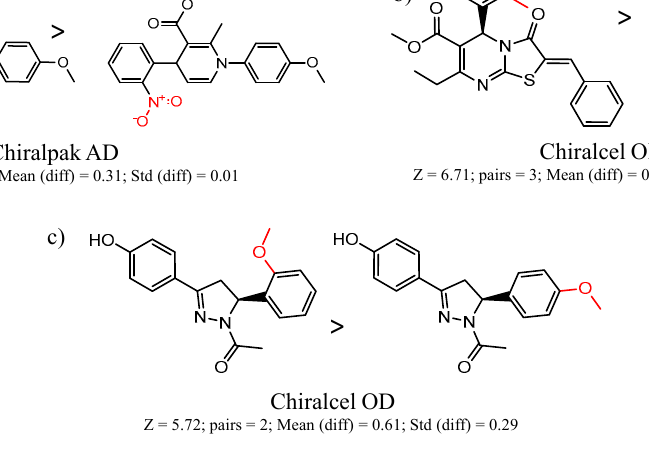
Figure 8. Matched Molecular Pairs illustrating the effects of ortho substitution on chiral recognition.